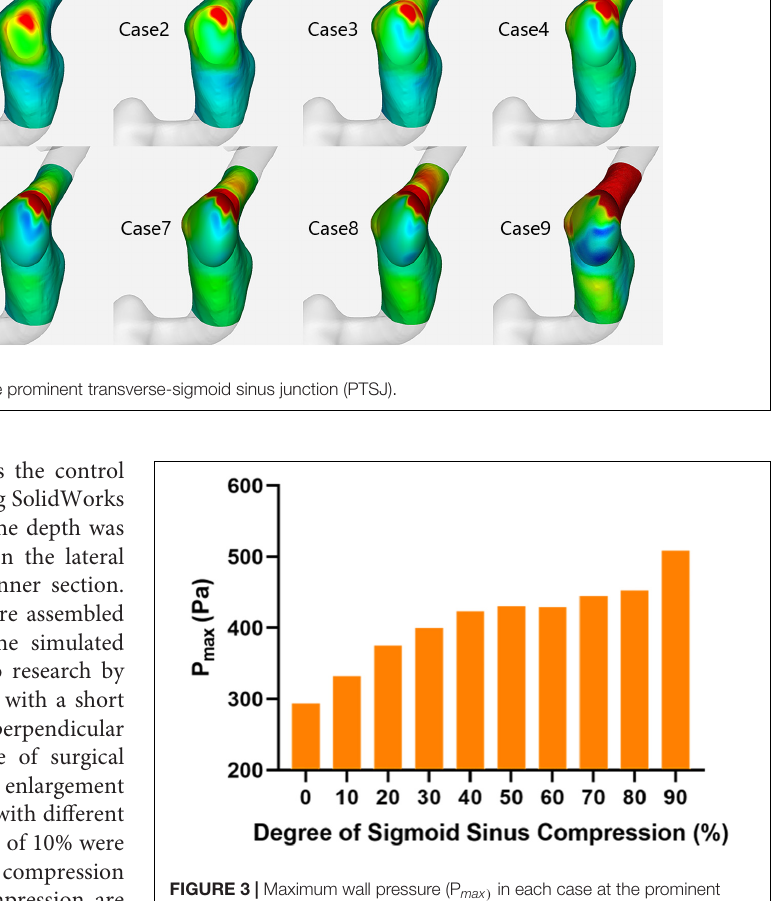
FIGURE 3 | Maximum wall pressure (P max ) in each case at the prominent transverse-sigmoid sinus junction